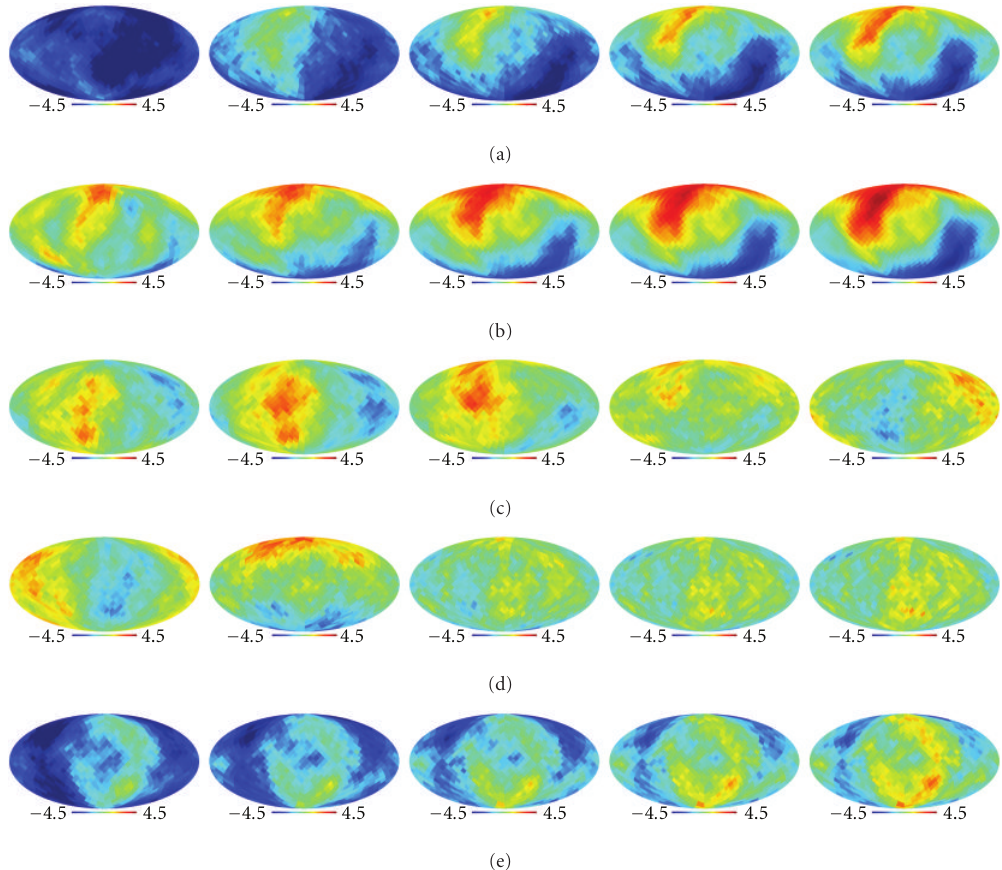
Figure 12: Same as Figure 11 but for the needlet-based NILC5